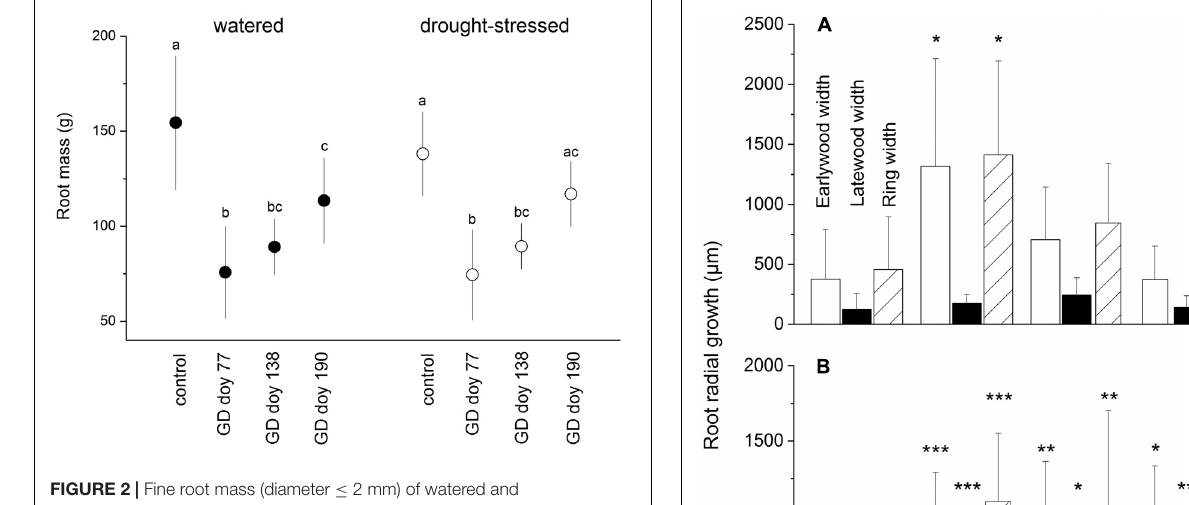
FIGURE 2 | Fine root mass (diameter ≤ 2 mm) of watered and drought-stressed trees (filled and open circles, respectively) at the end of the study period. Significant effects of girdling within a soil moisture treatment are indicated by different letters ( P ≤ 0.01; Student’s independent sample t -test). Bars indicate standard deviations.